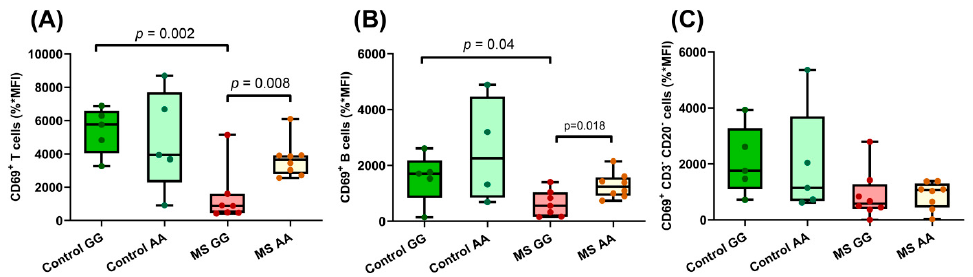
Figure 3. Immune cell activation upon PHA stimulation regulated by rs7665090. The effect of rs7665090 genotypes in CD69 surface expression of ( A ) CD3 + CD20 − lymphocytes (controls GG n = 5; controls AA n = 5; MSGG n = 7; MS AA n = 8). Percentage of difference between means in Control GG vs. MS GG = 73.82 ± 17.21%; MS GG vs. MS AA = 61.65 ± 19.8%; ( B ) CD3 − CD20 + lymphocytes (controls GG n = 5; controls AA n = 4; MS GG n = 7; MS AA n = 8). Percentage of difference between means in Control GG vs. MS GG = 58.62 ± 25.35%; MS GG vs. MS AA = 50.26 ± 18.63%; and ( C ) CD3 − CD20 − lymphocytes (controls GG n = 5; controls AA n = 5; MS GG n = 8; MS AA n = 8). MFI (median fluorescence intensity) × % of CD69 + cells ± standard deviation is shown. Box and whiskers diagrams: the line represents the median value, the box the 25 and 75 percentiles and whiskers mark maximum and minimum values. All comparisons were performed with Student’s t test.